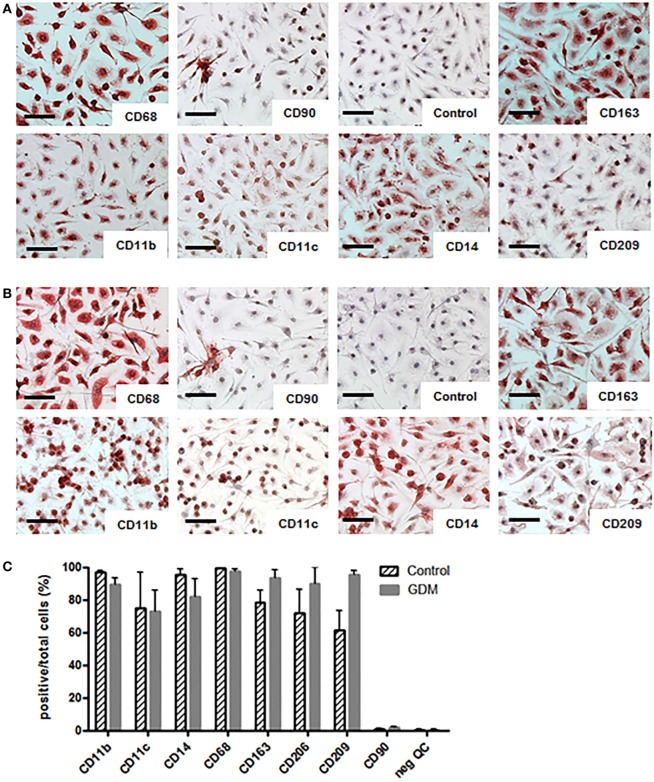
Immune cytochemistry (ICC) for M1 and M2 markers on isolated Hofbauer cells (HBCs). (A) HBCs isolated from human placenta after normal pregnancy; (B) HBCs isolated from human placenta of gestational diabetes mellitus (GDM) pregnancy. CD68 was used as pan-macrophage marker independent of M1/M2 polarization. CD90 was used to staining contamination with fibroblasts. Anti-mouse-IgG isotype control served as negative control. CD163 and CD209 were used as markers of the M2 phenotype. CD11b in combination with CD11c are markers for M1 macrophages as well as CD14 Images shown are representative of four experiments per group. Scale bar = 200 μm. (C) Quantification of ICC; positive cells for each marker were stated relative to the total number of cells; all data are shown as mean ± SD, one-way ANOVA.